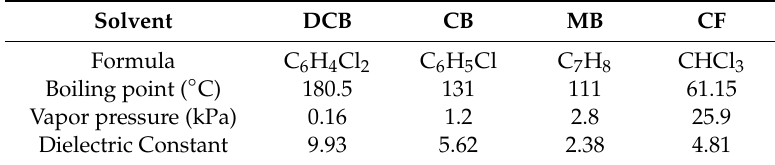
Figure 1. The chemical structures of the ( a ) 1,2-dichlorobenzene (DCB), ( b ) chlorobenzene (CB), ( c ) methylbenzene (MB), and ( d ) chloroform (CF) solvents. Table 1. The physical and chemical properties of the DCB, CB, MB, and CF solvents.